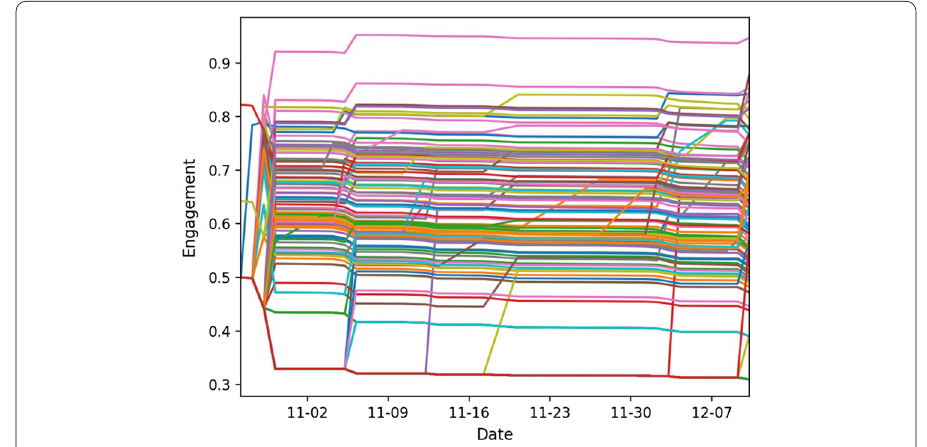
Fig. 6 A plot showing the changes in learner engagement over